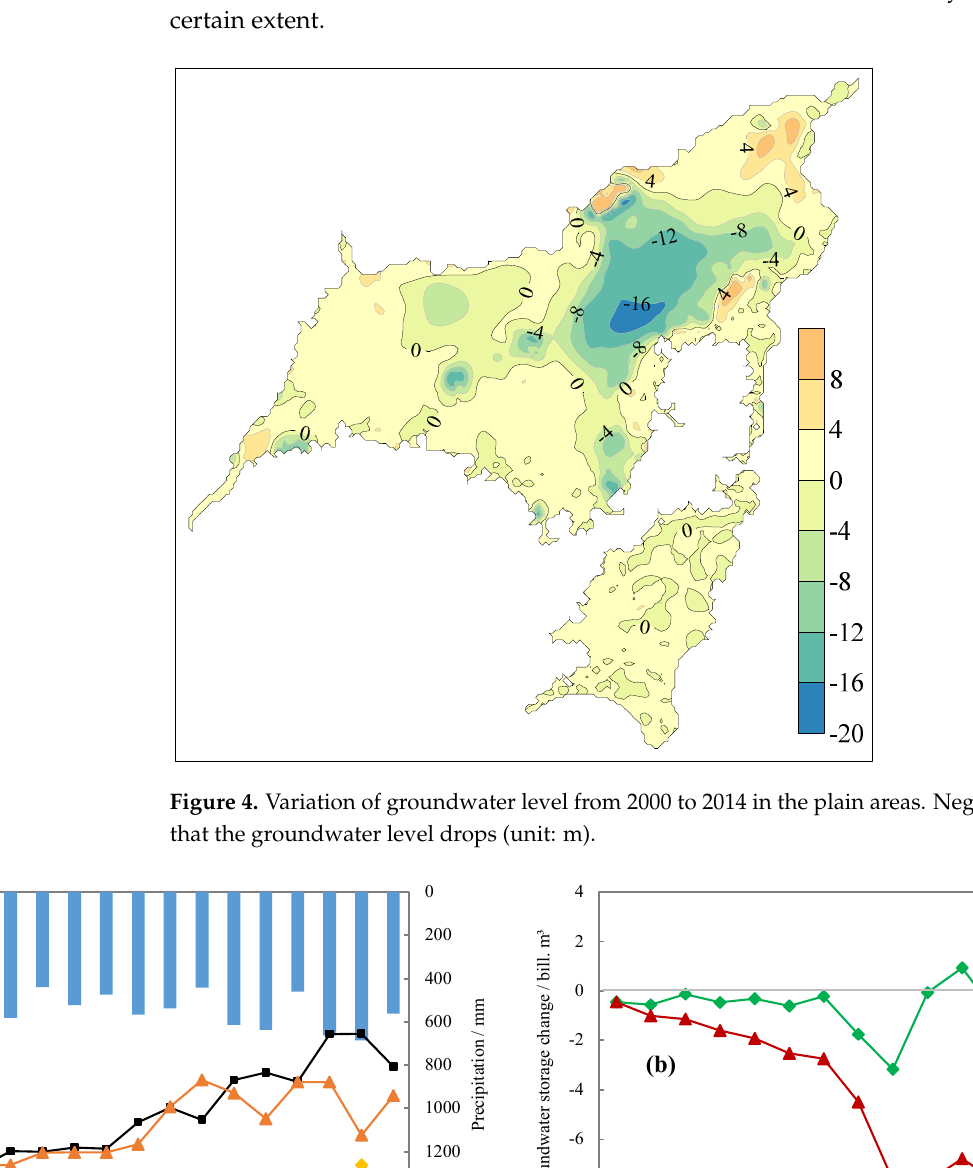
Figure 4. Variation of groundwater level from 2000 to 2014 in the plain areas. Negative values mean that the groundwater level drops (unit: m).